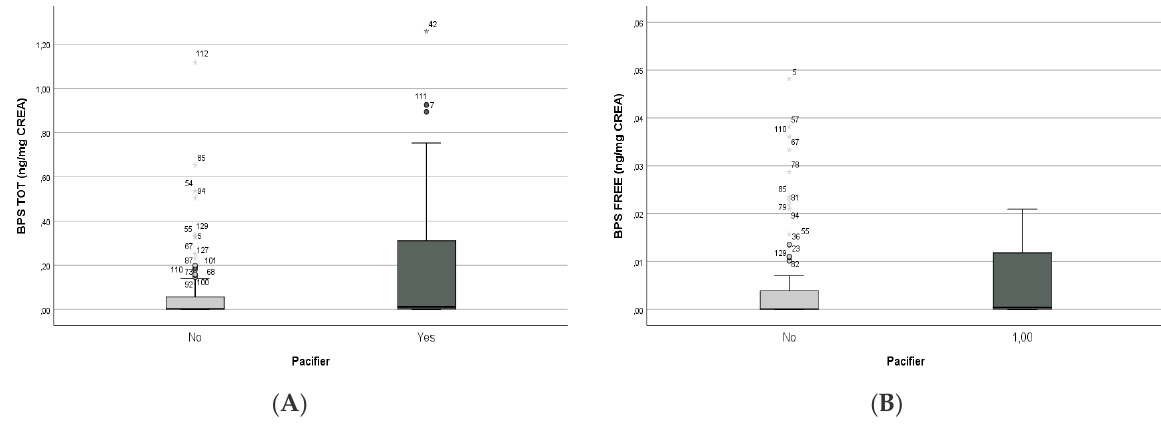
Figure 1. Non-parametric correlations between pacifier use and BPS total ( A ) and free BPS ( B ) concentrations in newborns.